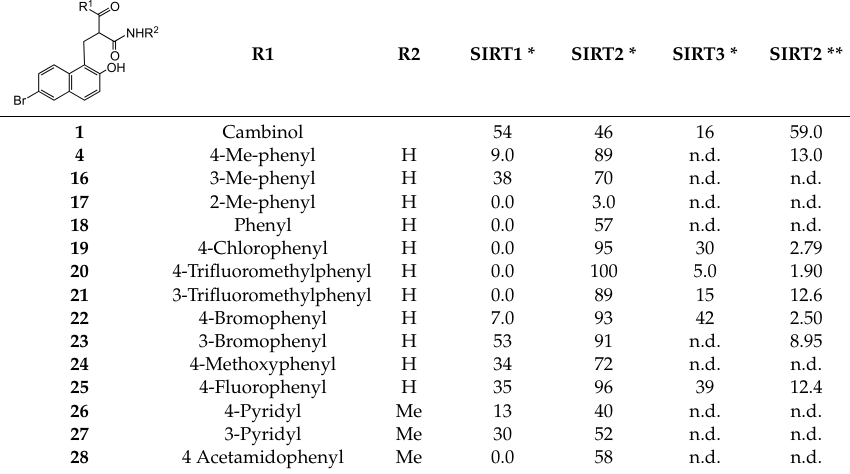
(Table 1) was used. Promising compounds were evaluated by a full dose-response curve to ascertain IC 50 against each of the sirtuin isoforms. Table 1. Optimization of the phenyl group (R 1